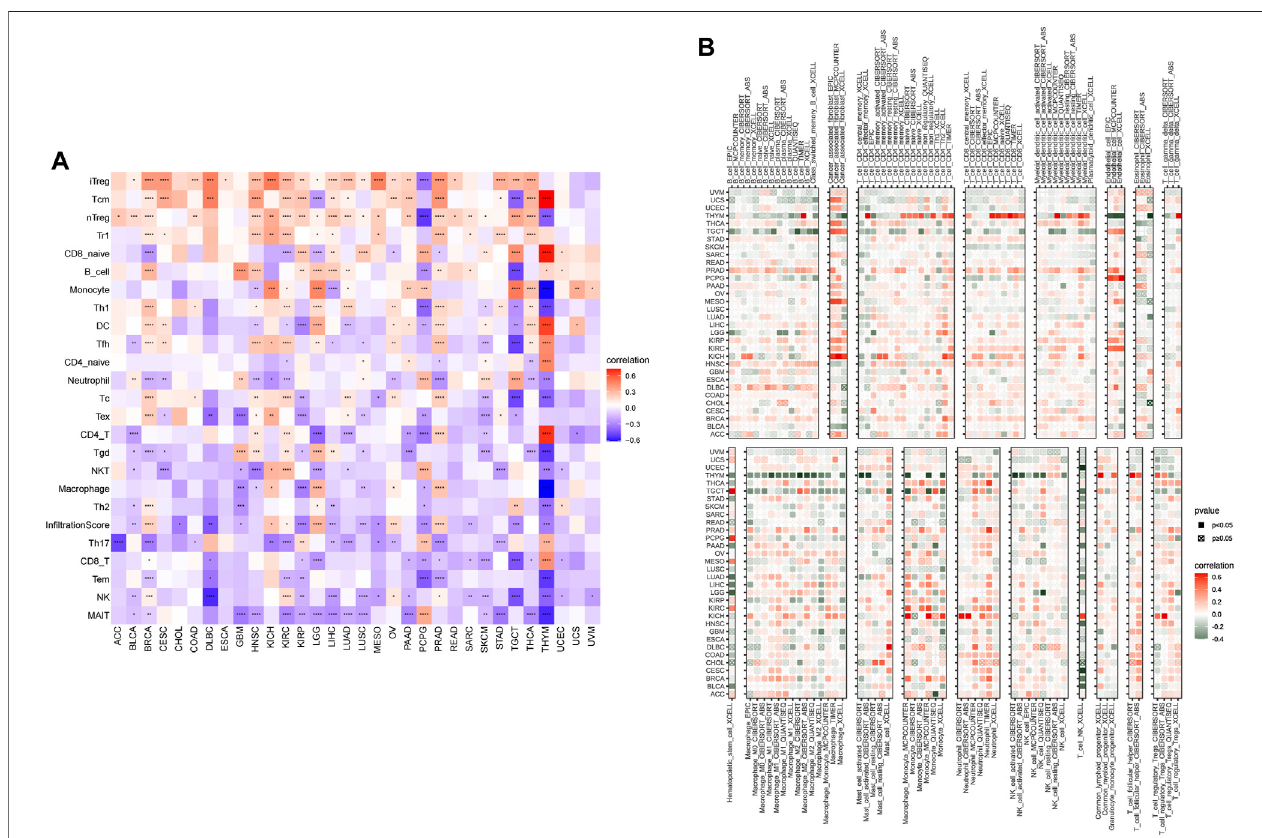
FIGURE 11 | The correlation of senescence score (SS) with the immune cells in fi ltration. (A) Correlation of SS with immune cells in fi ltration in cancers based on the ImmuCellAI database. (B) Correlation of SS with immune cells in fi ltration in cancers based on the TIMER2 database. Red represents positive correlations and blue represents negative correlations. Darker color represents stronger correlations (Spearman correlation, p < 0.05 was considered signi fi cant, * p < 0.05, ** p < 0.01, *** p < 0.001, and **** p <